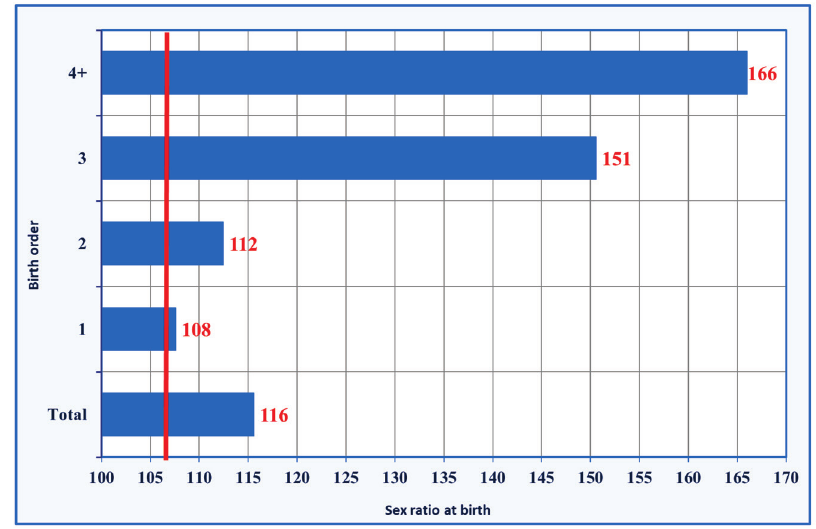
Figure 12. Sex ratio at birth in Azerbaijan by birth order, 2013. Source: based on SSC